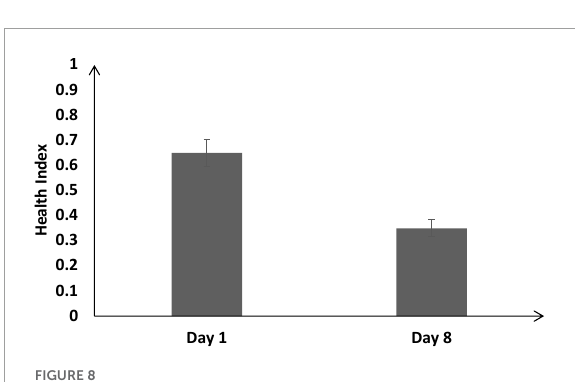
FIGURE8 The health index across different baseline days (Day 1 and Day 8). The error bars show 95% CI around point